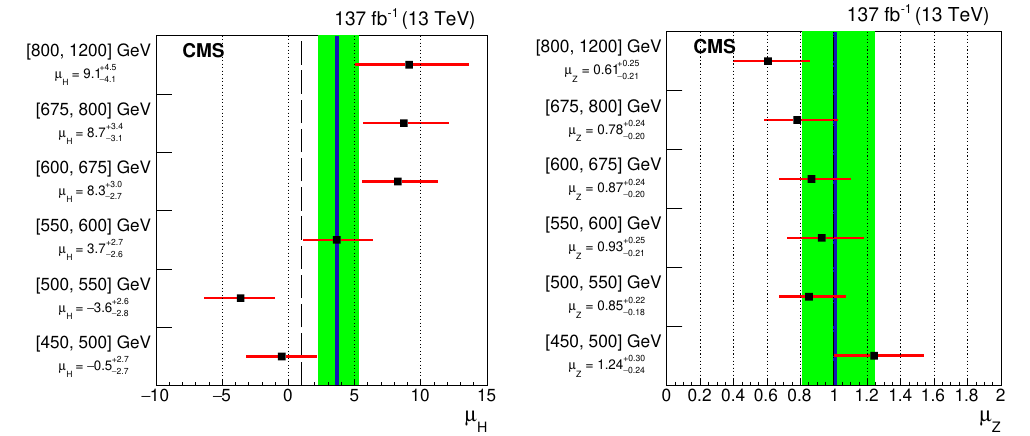
Figure 5 . The best-fit signal strength µ category based on the HJ-MiNLO [32, 33] prediction (left) and the same for µ dashed black line indicates the SM expectation. The solid blue line and green band represents the combined best-fit signal strength and uncertainty, respectively, of µ extracted from a simultaneous fit of all categories.